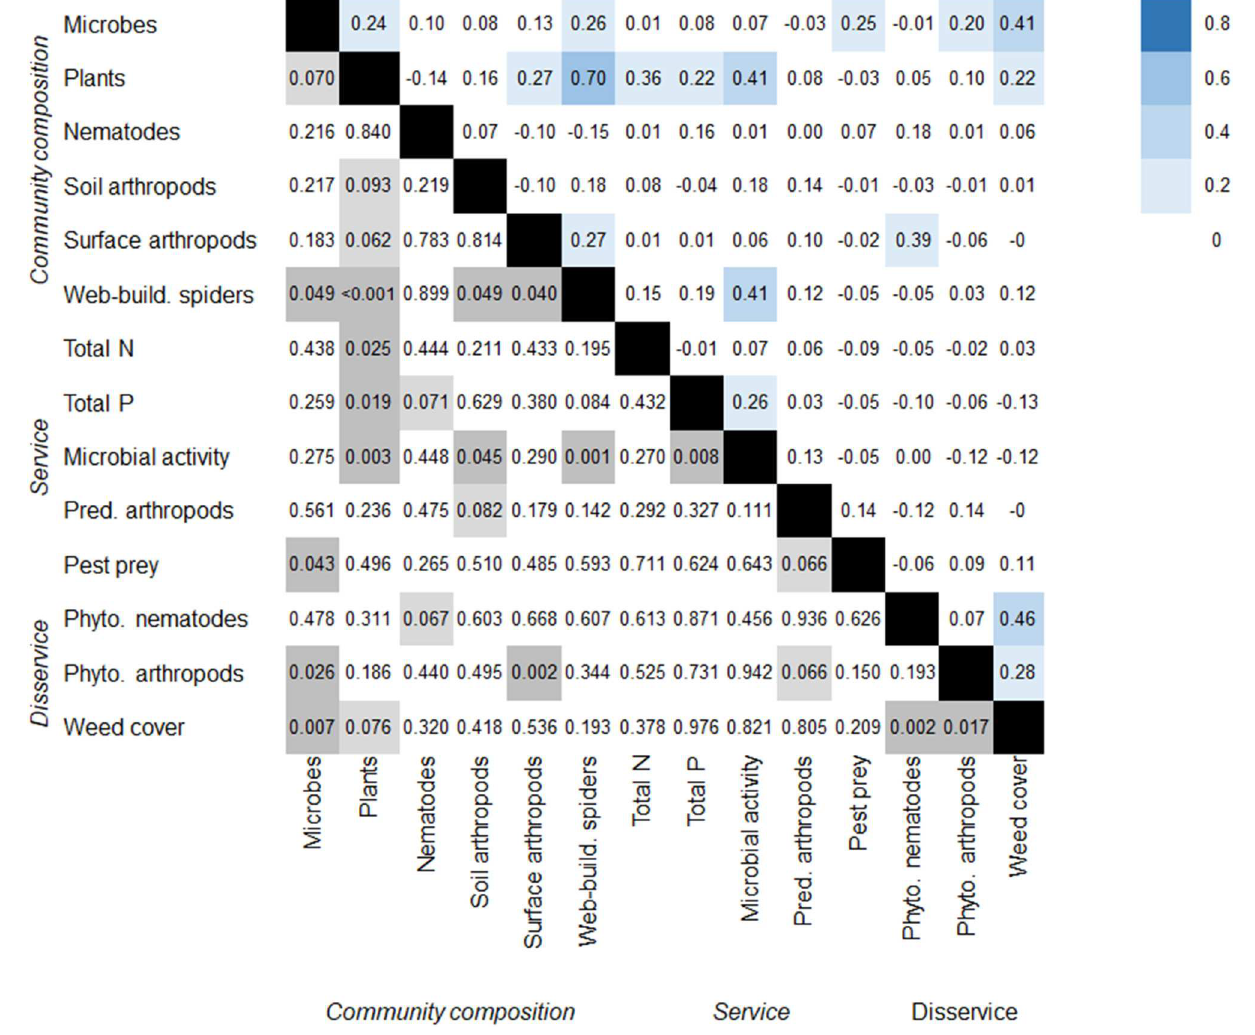
FIGURE 3 | Correlation matrix between community composition and potentials for ecosystem services and disservices with the upper triangle giving Spearman correlation coefficients and the lower triangle providing the respective P -values from matrix correlations (Mantel tests based on Spearman correlation coefficients). Individual Spearman r s are significant at the p < 0.05 if r s > |0.40|, n = 18. Note that for plant community composition and weed cover N = 16 and r s are significant at the p < 0.05 if r s >